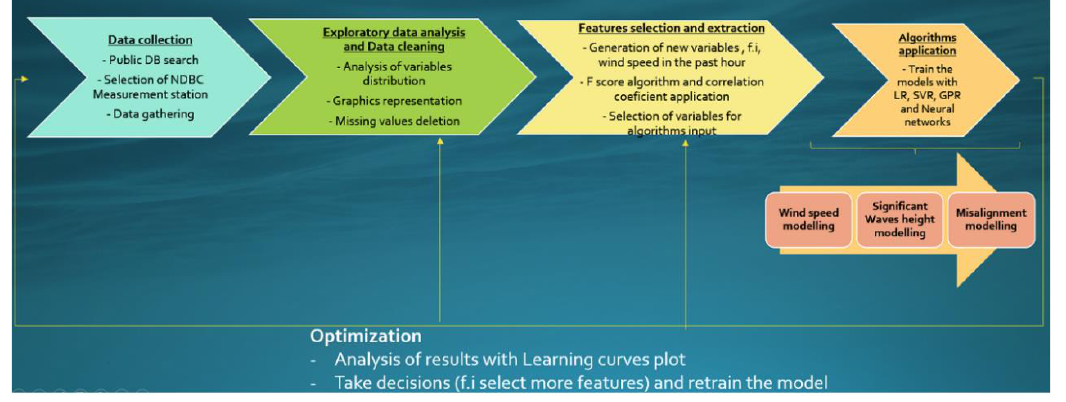
Figure 1. Machine learning flow chart. Table 1. Acronyms used.